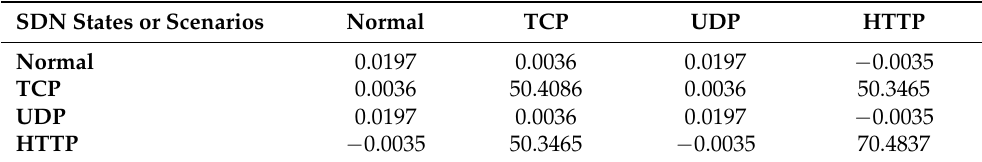
Table 5. Covariance matrix for T p when the SDN is operating normally and subjected to popular variants of DDoS flooding attacks.